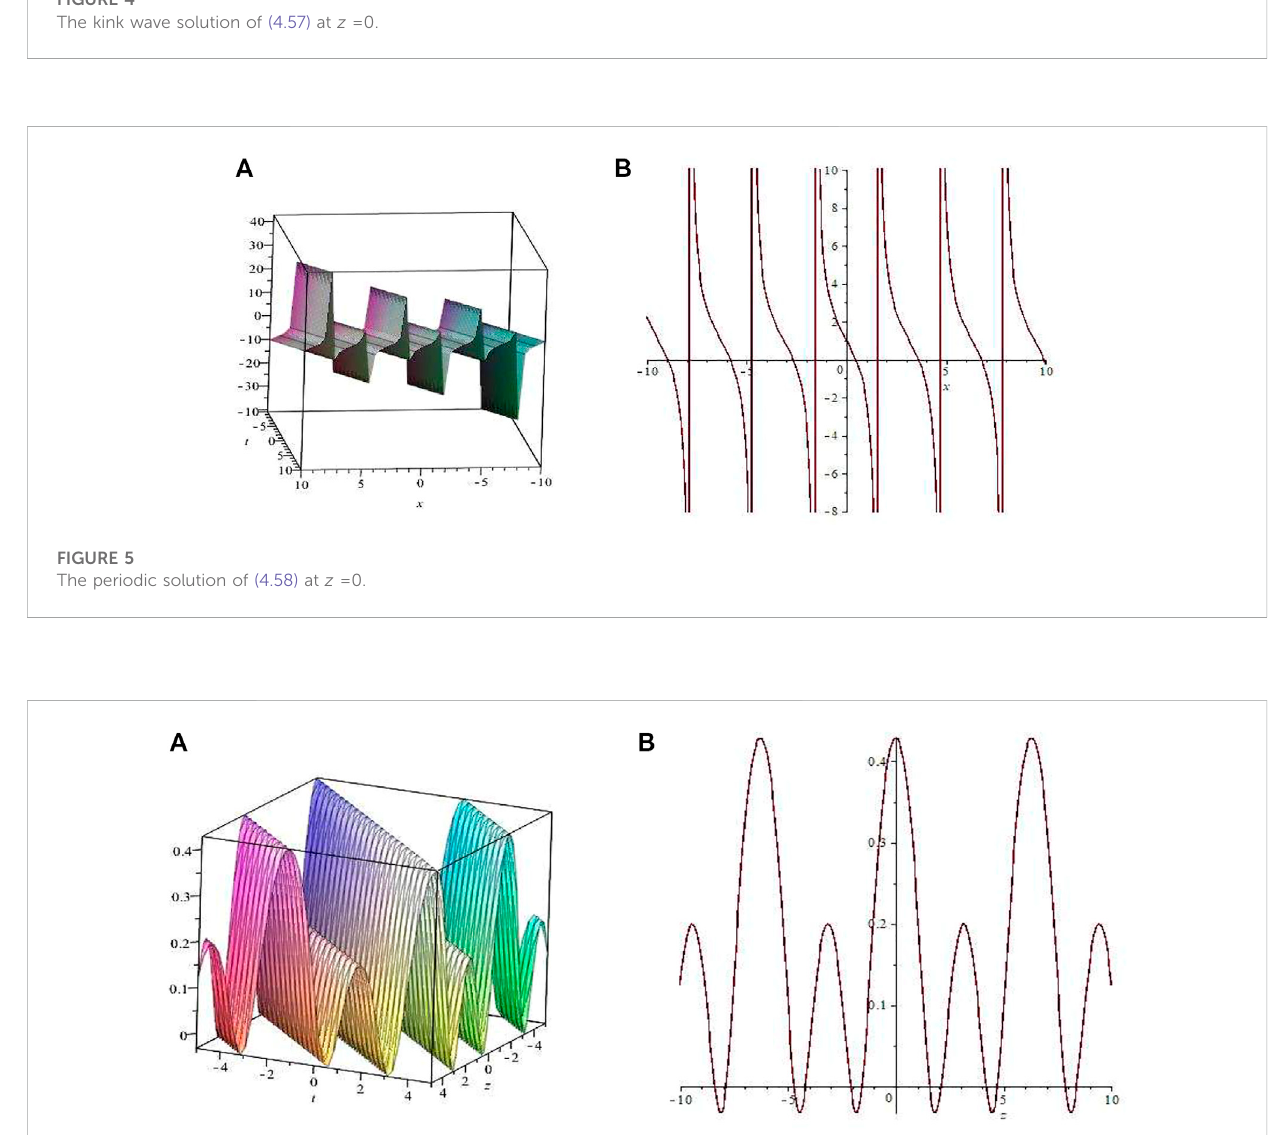
FIGURE 6 The symmetric two-periodic solution of